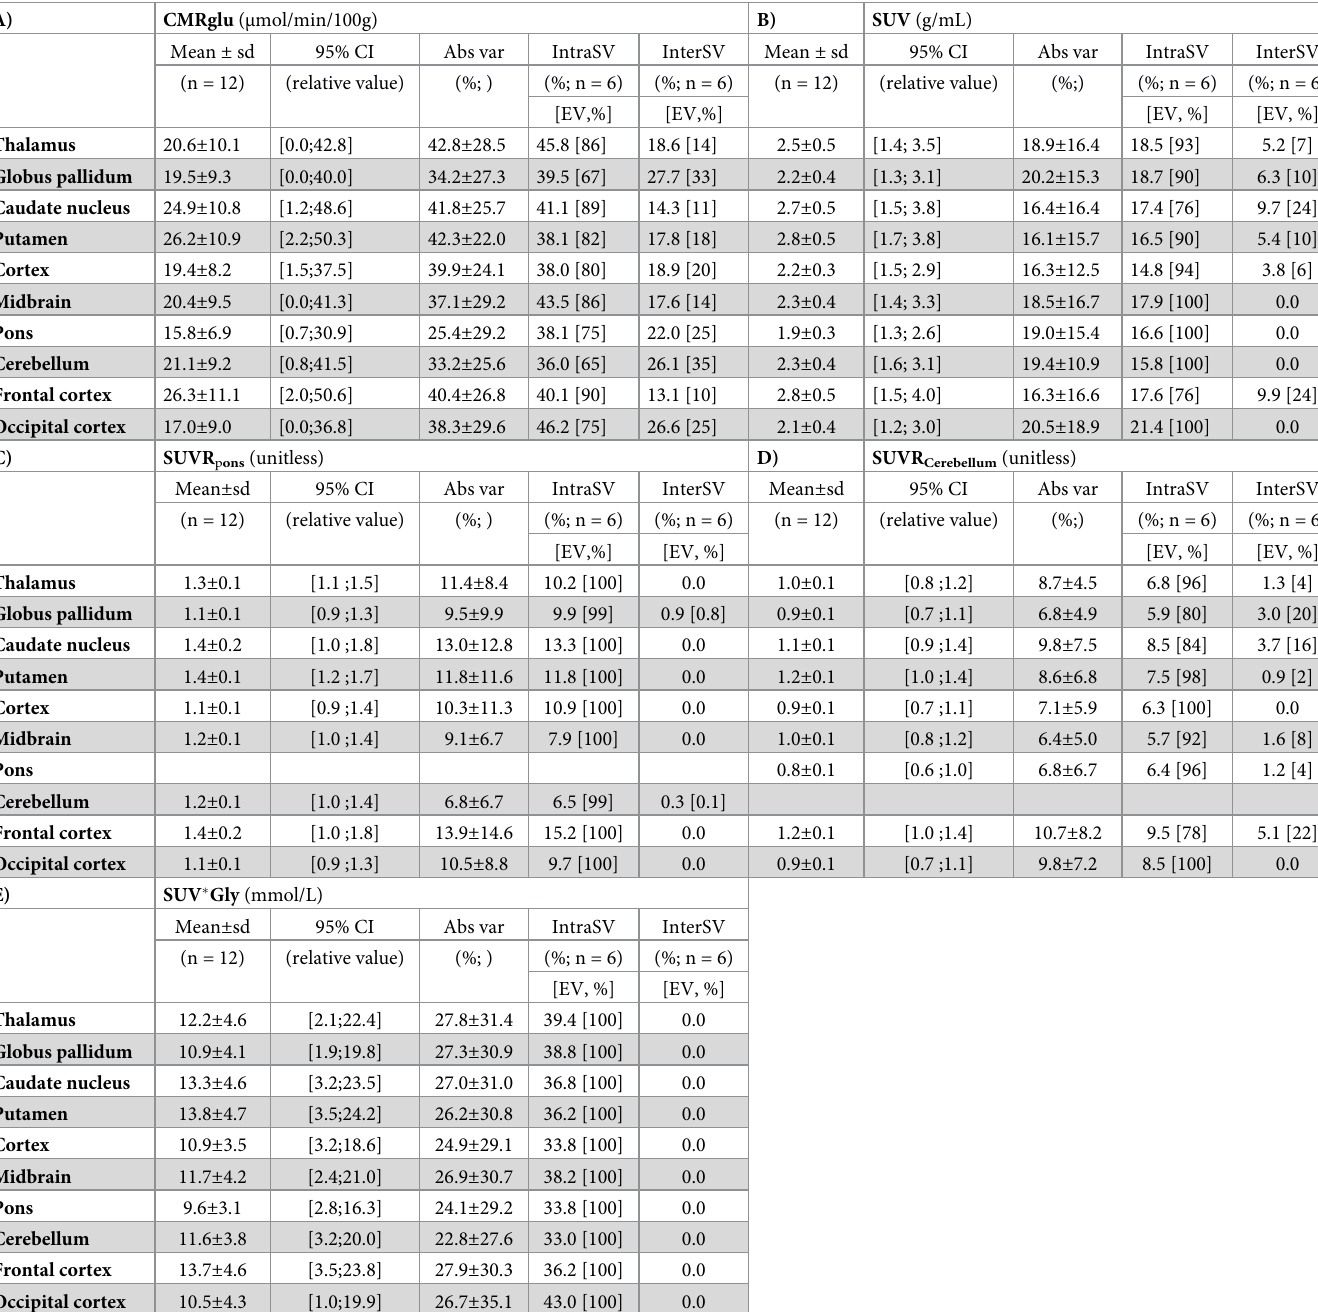
Table 1. Mean, confidence interval, total, intra- and inter-subject variabilities of outcome parameters between [ 18 F]FDG test and retest